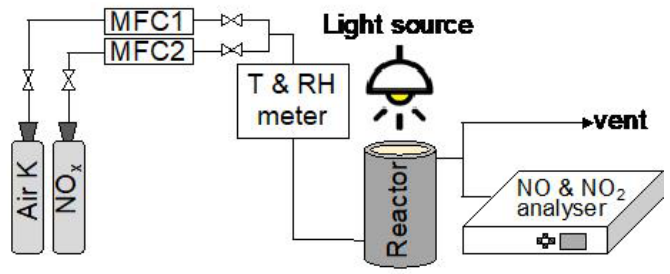
Figure 8. Experimental layout.